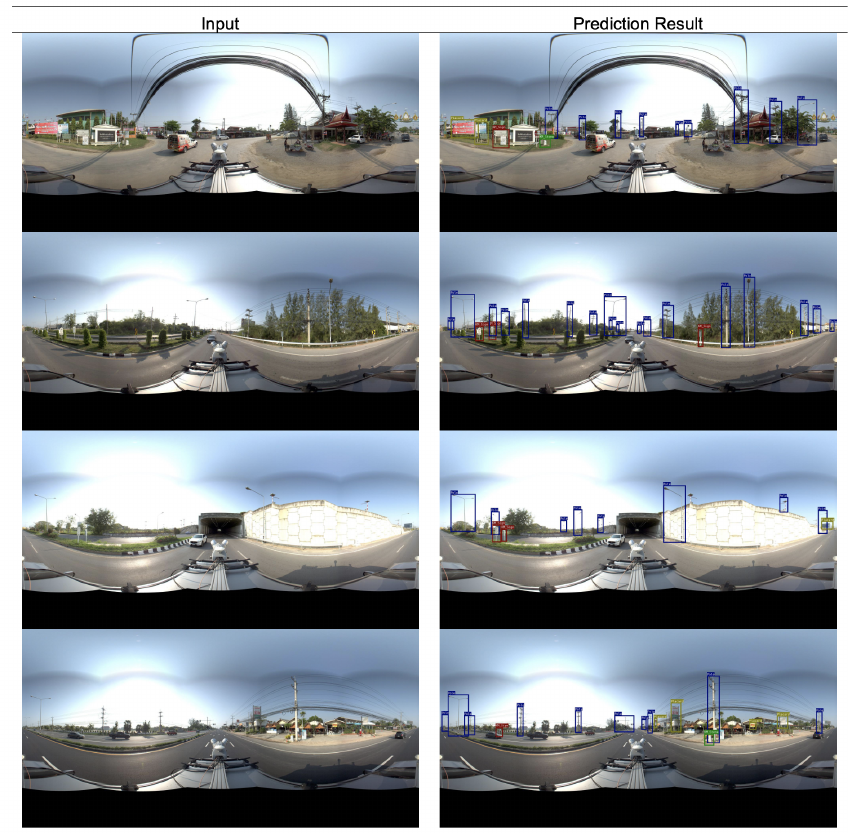
Figure 8. Visualized detection results of YOLOX-Transformer with FPN on an arbitrary image from Road Asset